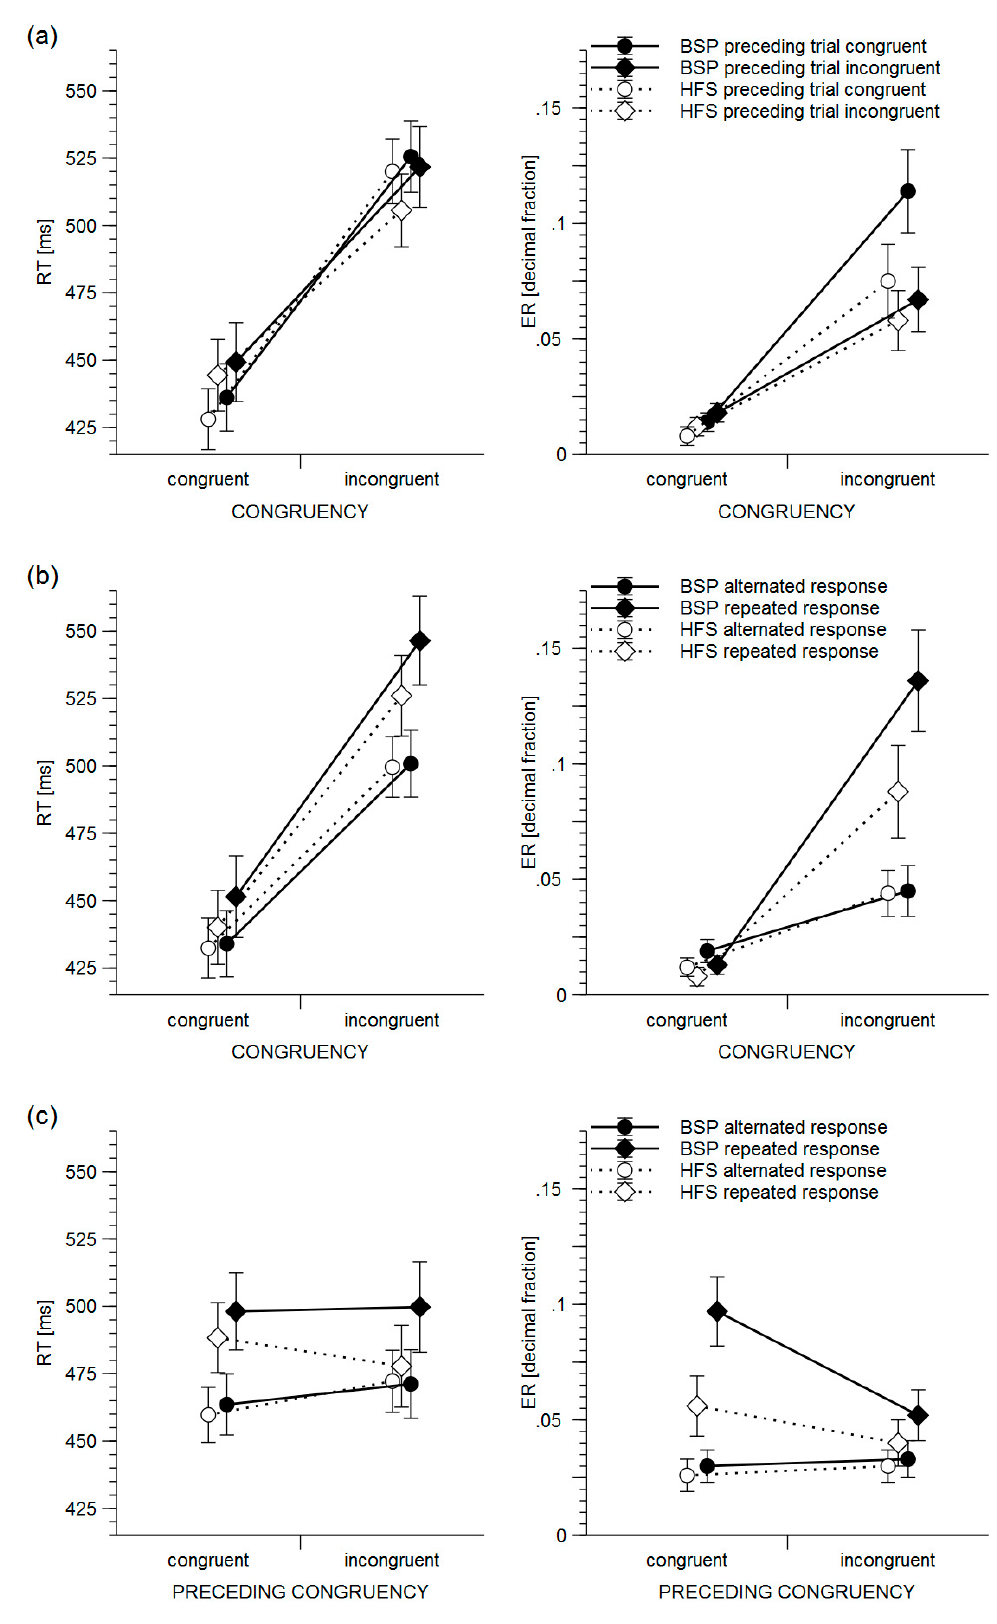
Figure 2. Reaction times (RTs) and error rates (ERs) separately for BSP and HFS patients. Error bars depict standard errors. ( a ) Congruency sequence effect, i.e., the interaction between preceding congruency, current congruency, and group. ( b ) Interaction between current congruency, response sequence, and group. ( c ) Interaction between preceding congruency, response sequence, and group.